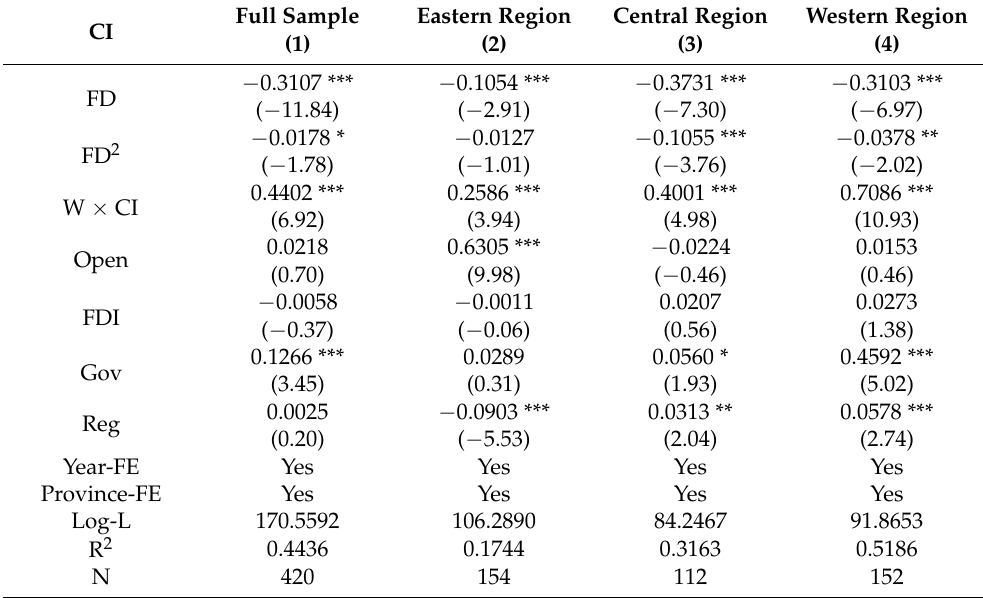
Table 5. Results of the impact of financial development on carbon intensity and the sub-regional heterogeneity analysis in non-linear models.